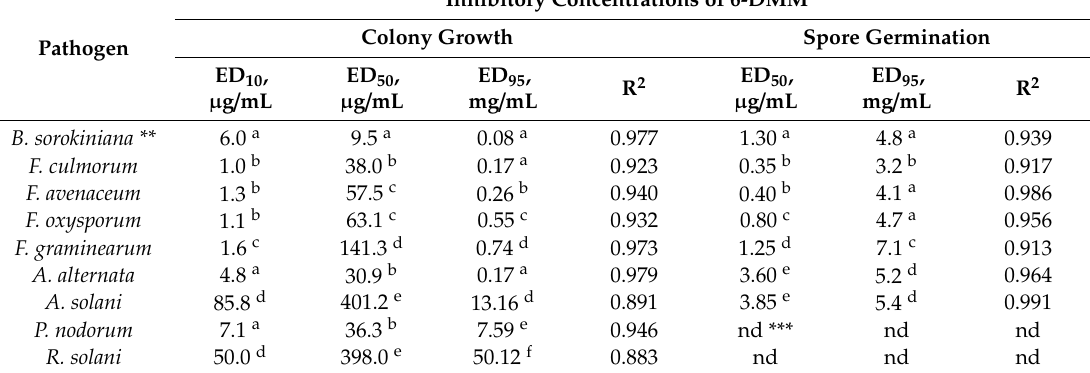
Table 1. Inhibitory concentrations of 6-dimethylmevinolin (6-DMM) for eight plant pathogenic fungi calculated by a probit analysis.